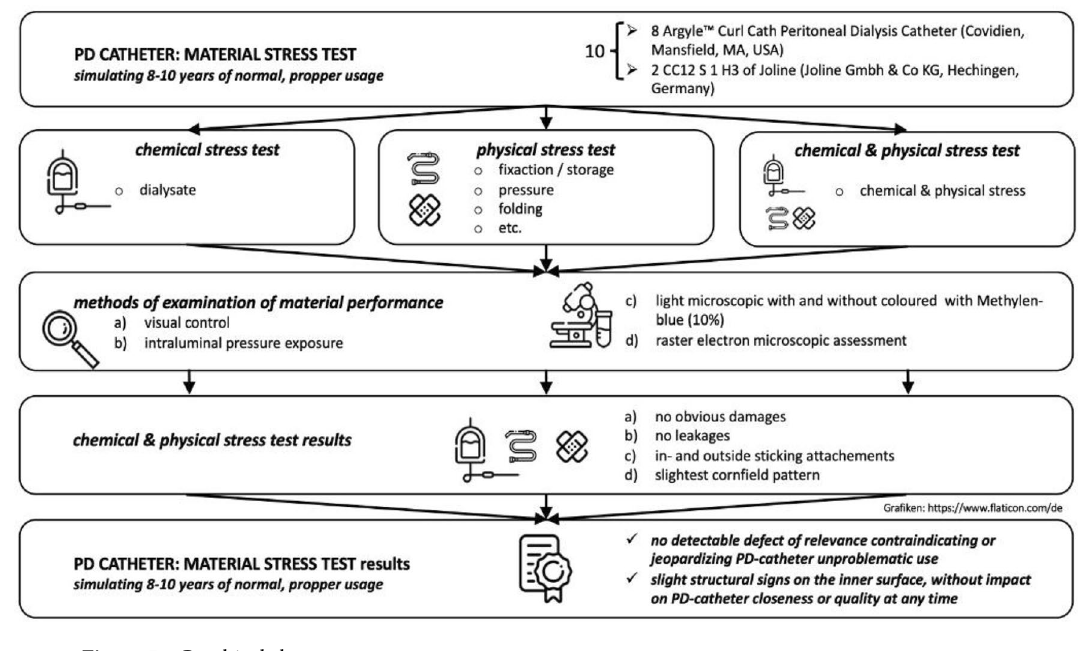
Figure 5. Graphical